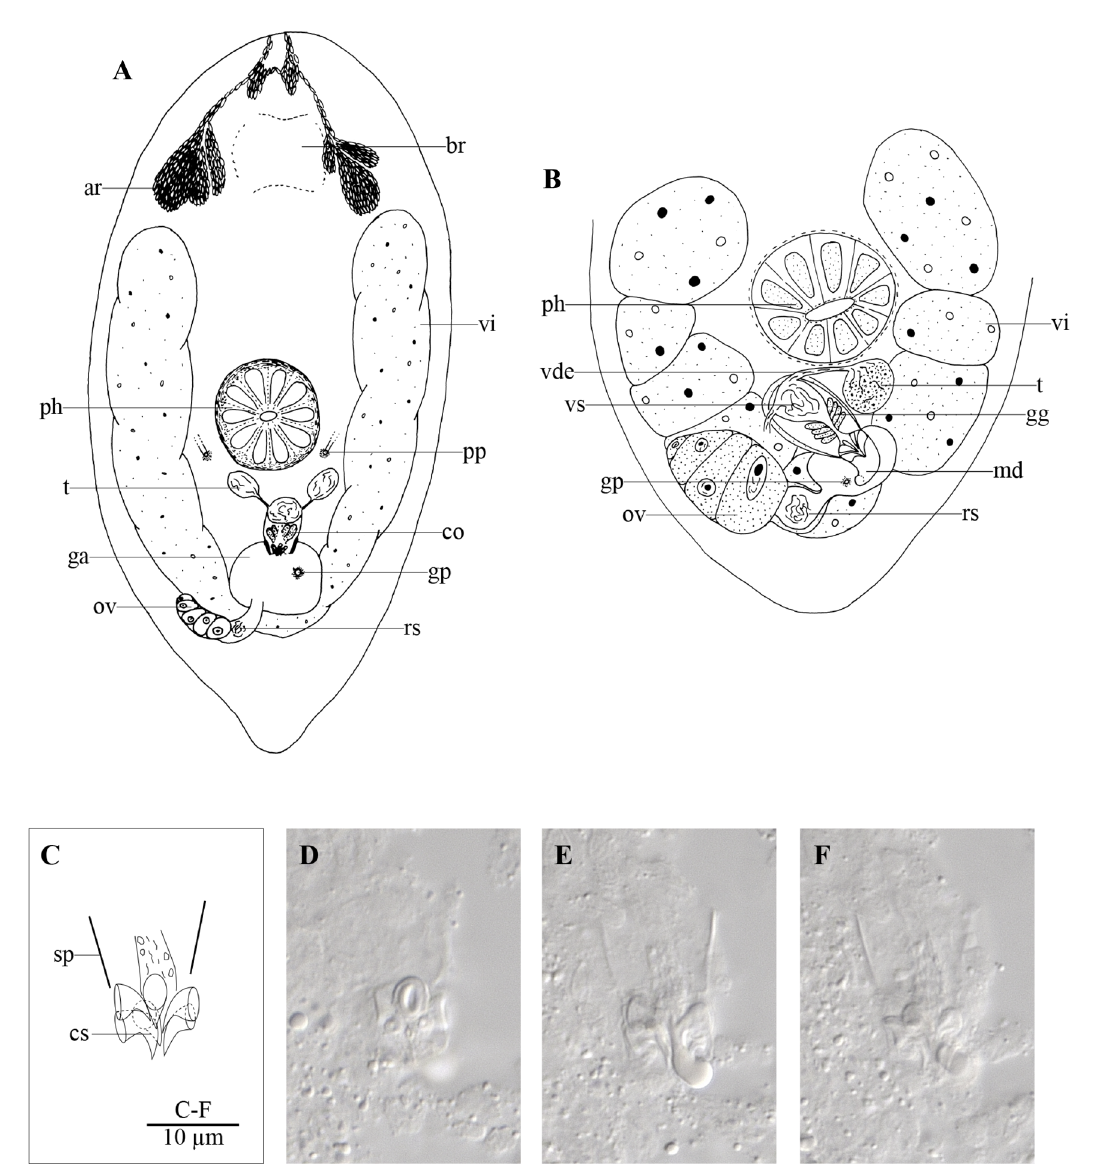
Fig. 4. Adenocerca minima Kolasa, 1981. A . Internal organisation of a live specimen. B . Reconstruction of reproductive organs based on horizontal sections. C–F . Male copulatory organ of the whole-mounted specimen